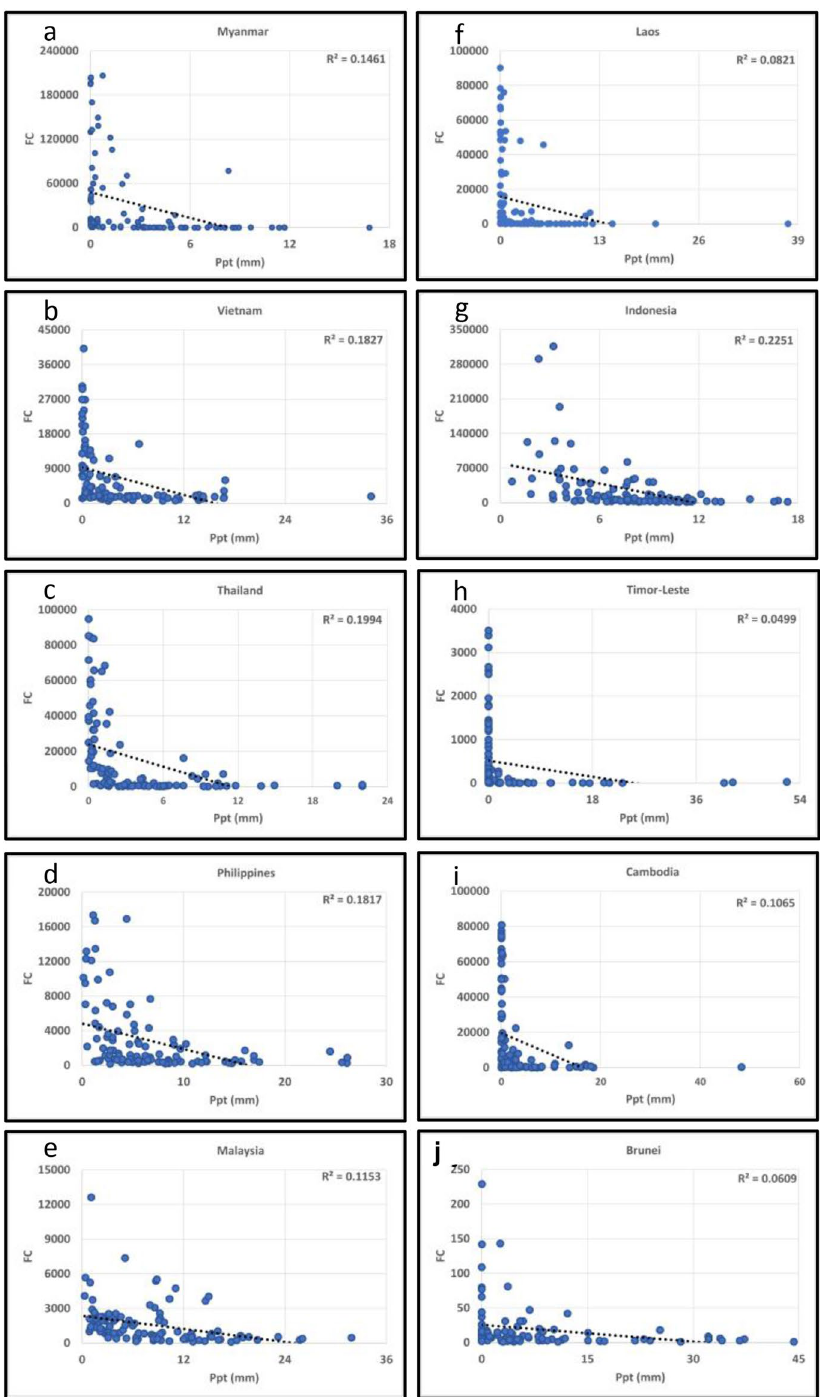
Figure 11. ( a )–( j ) Fire Counts (FC)-Precipitation (Ppt) relationships in Southeast Asian countries. Most of the correlations were poor, however, relatively, FC showed higher coefficient of determination with precipitation than